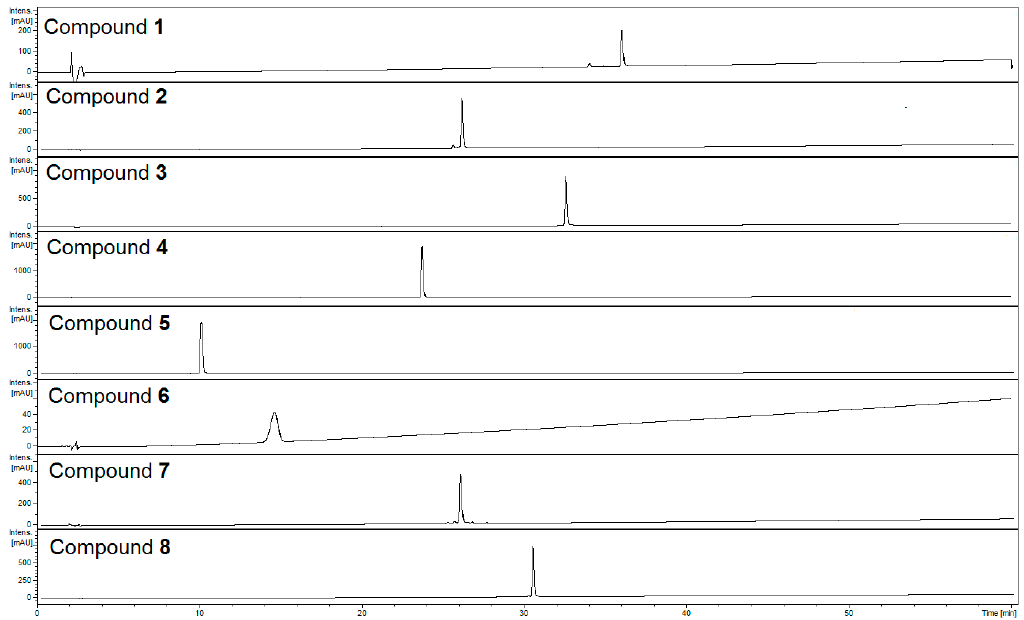
Figure 2. HPLC-chromatograms of isolated compounds recorded at λ = 240 nm. HPLC conditions: Zorbax SB-C 18 (150 × 2.1 mm, 1.9 µm), mobile phase: A. 0.1% HCOOH/H 2 O; linear gradient 0–60 min, 5% to 60% B. 0.1% HCOOH/MeCN.